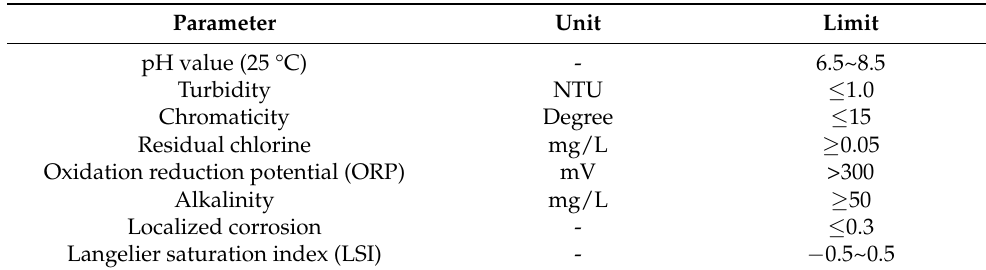
Table 1. Limits of water quality parameters for desalination seawater incorporated into urban water supply